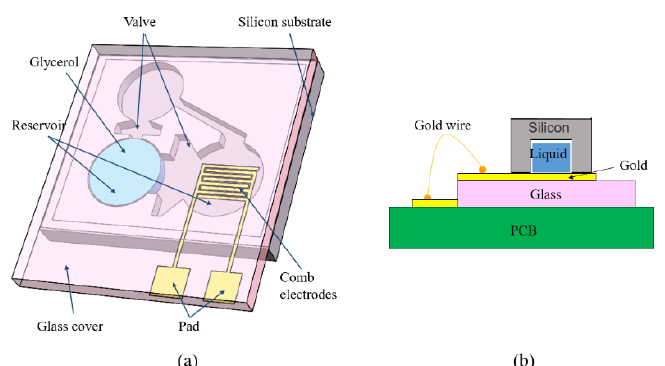
Figure 3. The schematic of a micro-drop inertial switch (Huang et al. 2013 [6]): ( a ) the overview; ( b ) the packing.